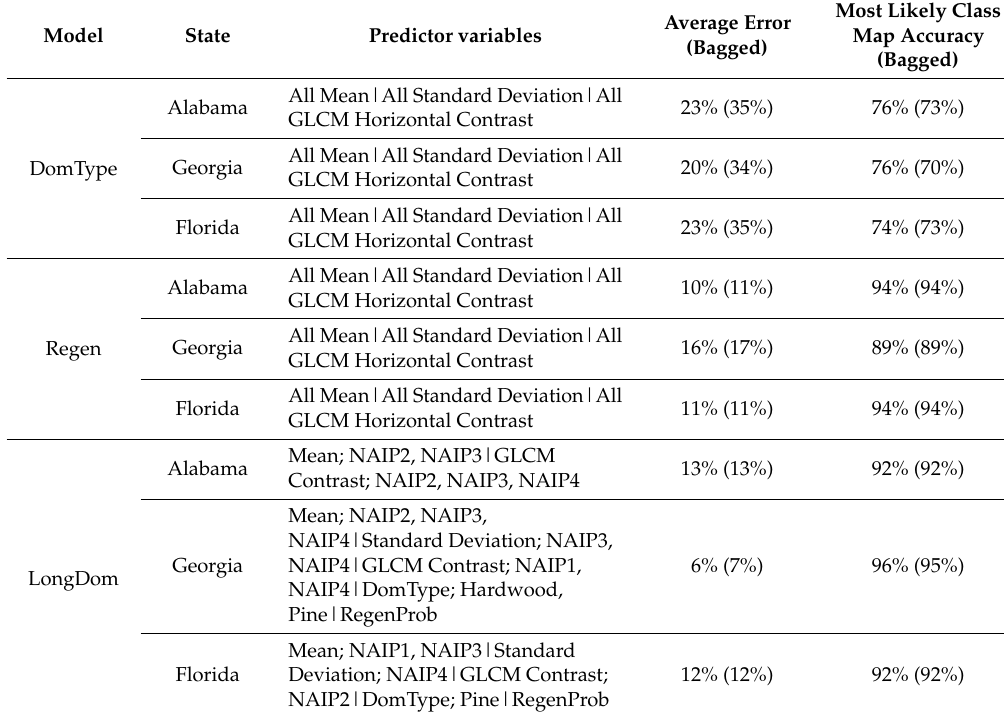
Table 5. Soft-max neural net predictor variables used and fit statistics for DomType and Regen models.